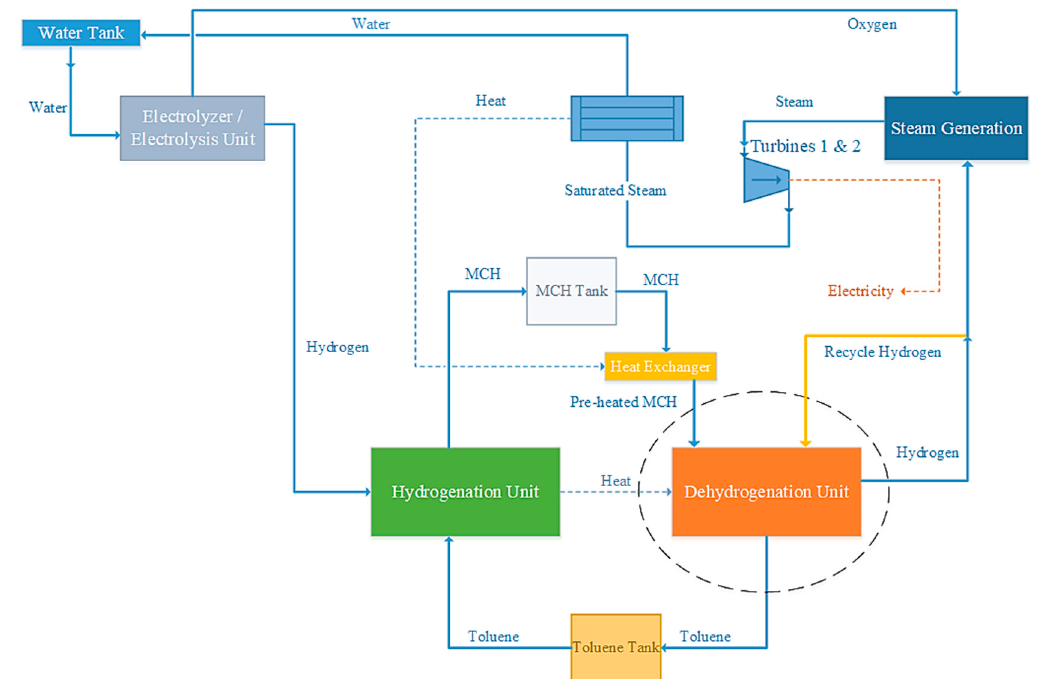
Figure 1. Overall schematic of the hydrogen-storage system (Adapted from [33]).